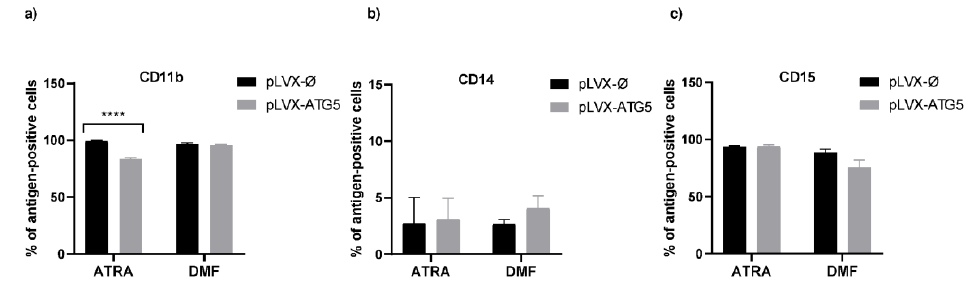
Figure 2. Increased expression of ATG5 affects the all-trans retinoic acid (ATRA)-induced differentiation of HL-60 cells. HL-60-ATG5 and mock control cells were differentiated into granulocyte-like cells by treatment with 1 µM ATRA or 70 mM dimethylformamide for 5 days. (a–c) Cells were harvested, stained with appropriate antibodies and differentiation was assessed by evaluating surface expression level of CD11b, CD14 and CD15 by flow cytometry. The data are presented as the means + SEM, n = 5 where n is the number of replicate experiments. **** p ≤ 0.0001 versus mock control, Kruskal–Wallis test with post-hoc Dunn’s test.